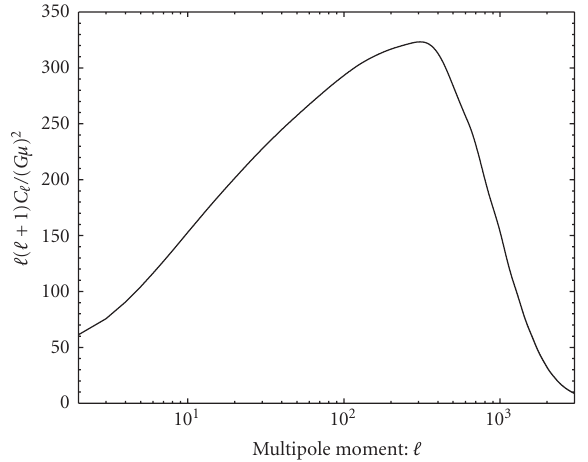
Figure 11: CMB temperature power spectrum induced by a network of Abelian cosmic strings and derived from the unequal time correlators method. Figure extracted from [194].